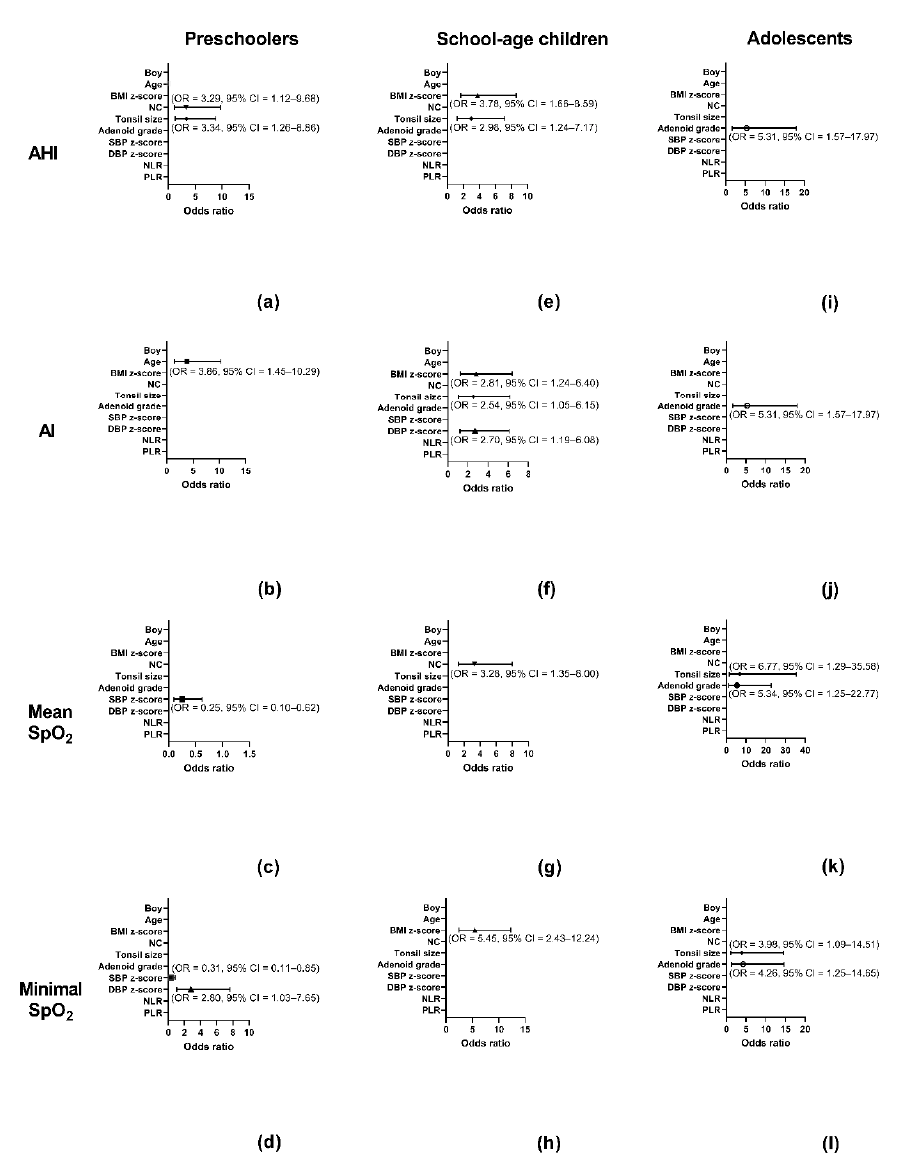
Figure 2. Variables (odds ratios and 95% confidence intervals) independently associated with AHI, AI, mean SpO 2 , and minimal SpO 2 in various age subgroups. In the preschoolers—( a ) high NC and tonsil size independently correlated with high AHI; ( b ) high age was independently correlated with high AI; ( c ) high SBP z-score was independently associated with low mean SpO 2 ; and ( d ) high SBP z-score and high DBP z-score were independently associated with low minimal SpO 2 . In the school-age children—( e ) high BMI z-score, tonsil size, and DBP z-score were independently correlated with high AHI; ( f ) high NC and adenoid grade were independently correlated with high AI; ( g ) high NC was independently associated with low mean SpO 2 ; and ( h ) high BMI z-score was independently correlated with low minimal SpO 2 . In the adolescents—( i ) high adenoid grade was independently associated with high AHI; ( j ) high adenoid grade was independently correlated with high AI; ( k ) high tonsil size and adenoid grade were independently correlated with low mean SpO 2 ; and ( l ) high tonsil size and adenoid grade were independently associated with low minimal SpO 2 . Abbreviations: AHI—apnea–hypopnea index; AI—apnea index; BMI—body mass index; CI—confidence interval; OR—odds ratio; NC—neck circumference; NLR—neutrophil-to-lymphocyte ratio; PLR—platelet-to-lymphocyte ratio; SBP—systolic blood pressure; DBP—diastolic blood pressure; SpO 2 —oxygen saturation measured by pulse